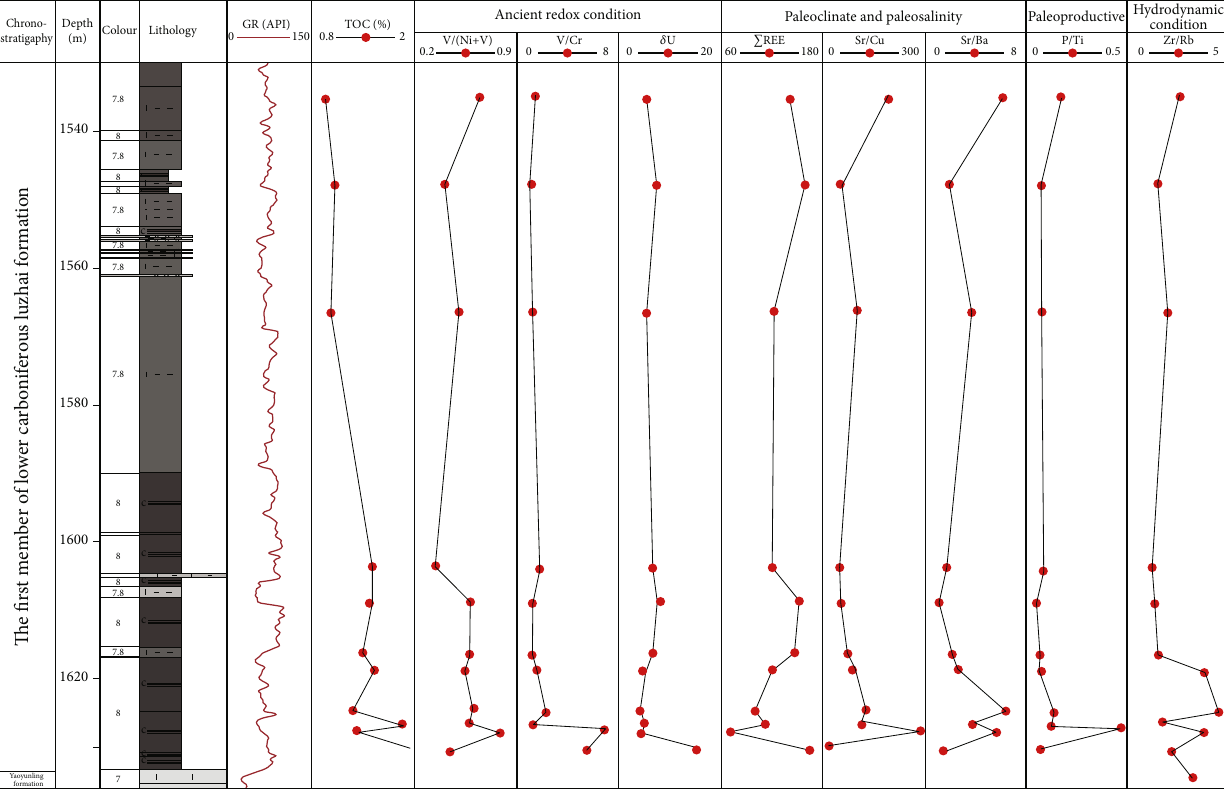
Figure 7: Paleoenvironment and paleoproductivity distribution of the fi rst member of the Carboniferous Luzhai formation in the well GRY1 in Rongshui area,